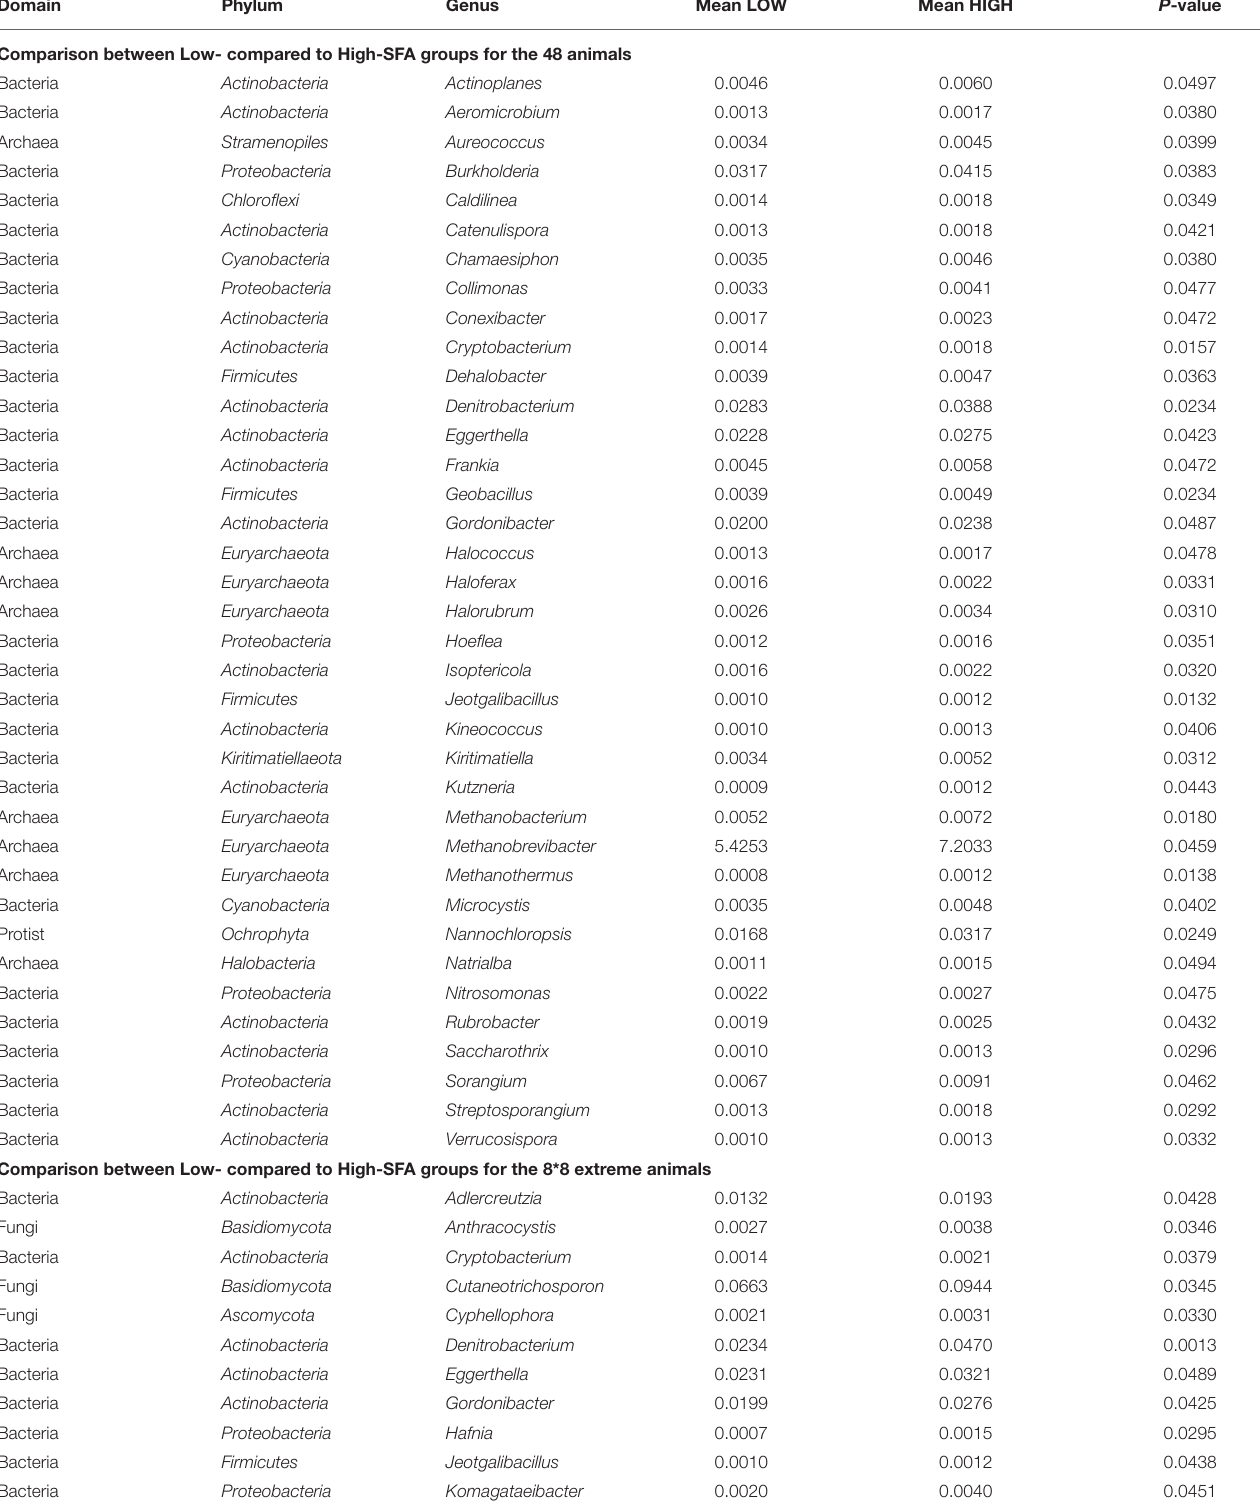
TABLE 1 | ANOVA (Bonferroni corrected) results for genera significantly different between Low- compared to High-SFA groups (based on all 48 animals).